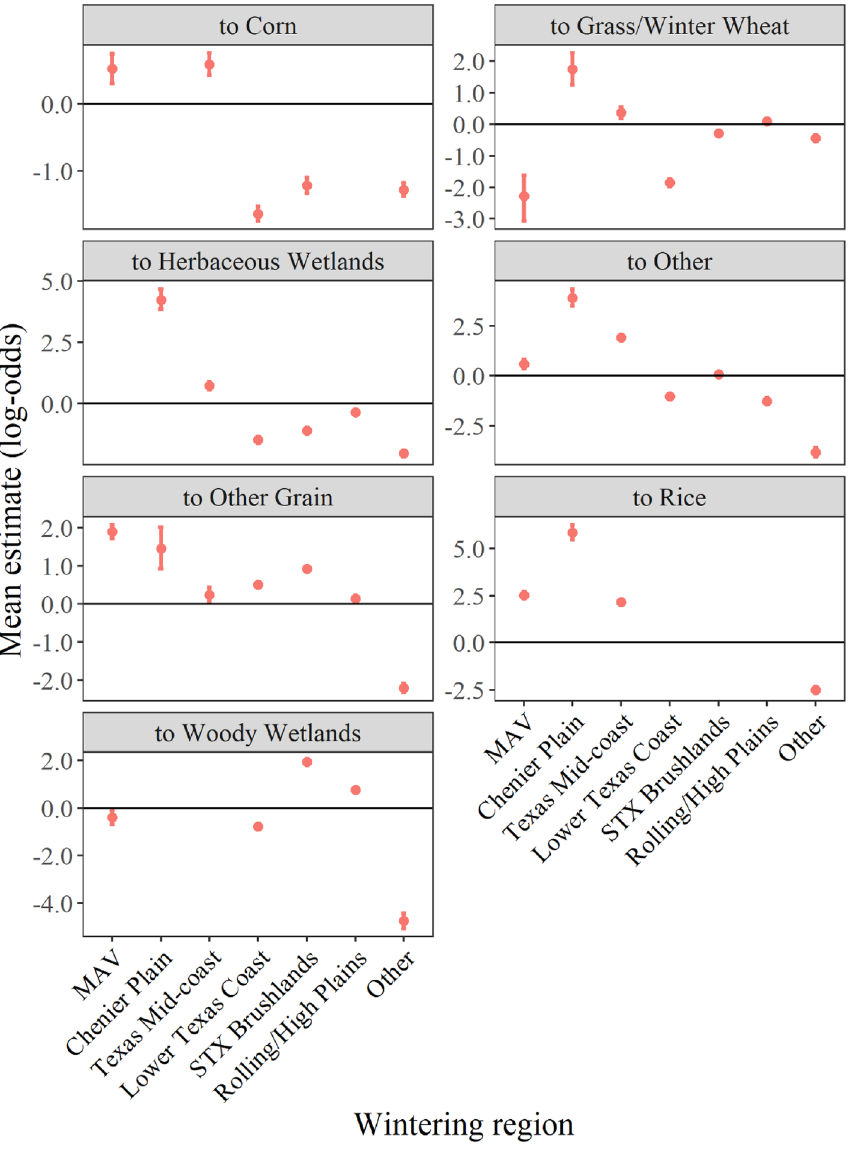
Figure 2. Mean effect on habitat-specific transition probability (± 95% credible intervals; log-odds scale) to each of seven landcover types for the specific wintering region selected by 56 greater white-fronted geese during winters 2016–2017 and 2017–2018. Note varying scales of the y-axis on each panel to show increased detail due to small credible intervals. Also, effects were not estimated for transitions that were not observed; for example, no estimate is reported for transitions to corn in Chenier Plains in the upper left